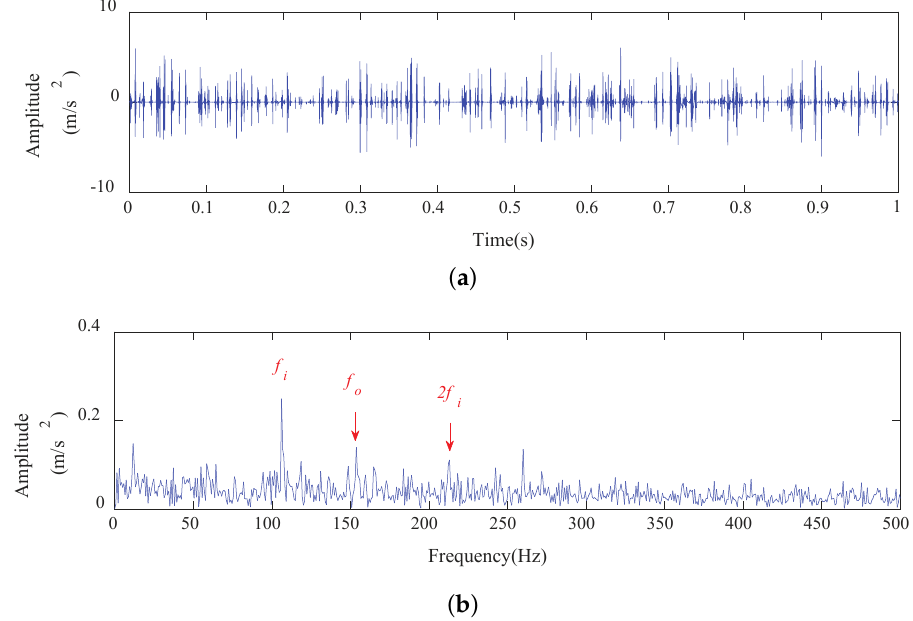
Figure 14. Results of the proposed weighted WOGS algorithm: ( a ) Time-domain waveform. ( b ) Envelope